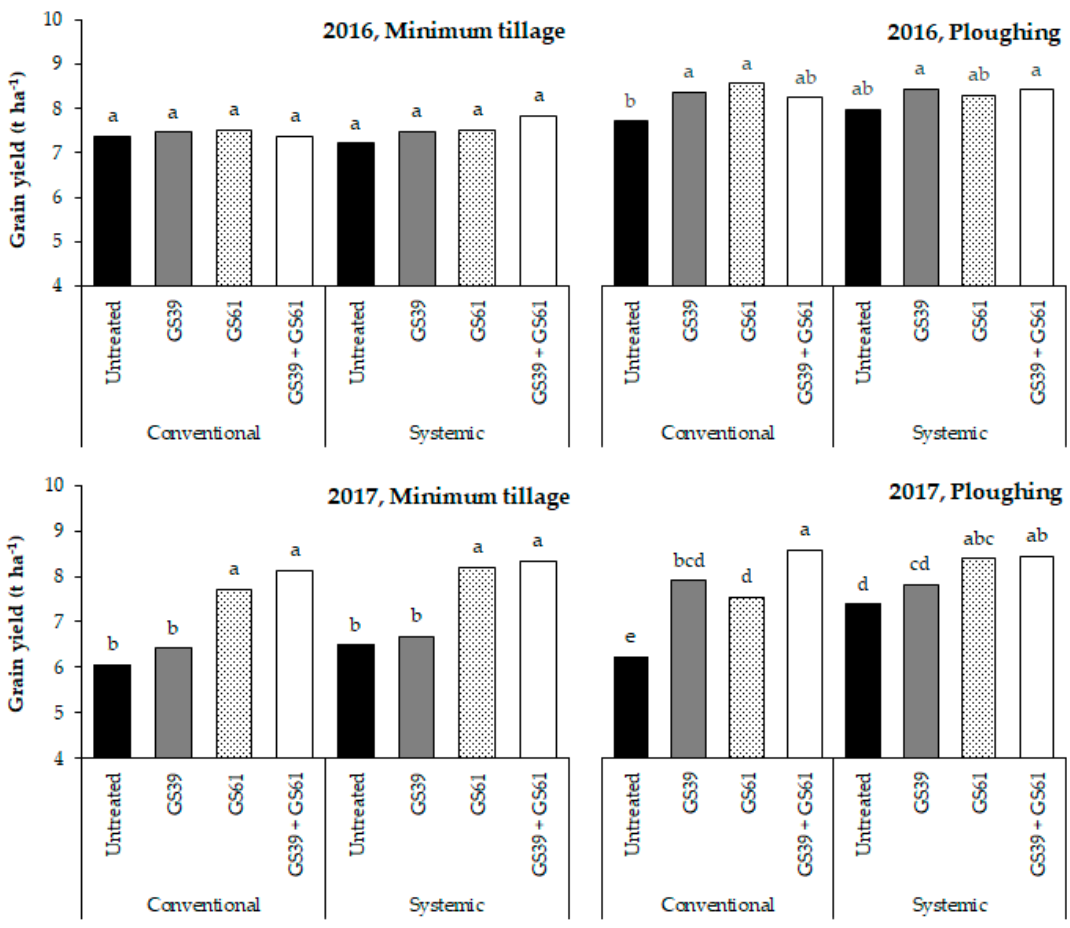
Figure 4. Effect of the fungicide seed 1 and foliar 2 treatments on the grain yield under different soil tillage conditions and in different growing seasons (2015–2016 and 2016–2017) in North-Italy. The bars in each experiment with different letters are significantly different ( p -value < 0.05), according to the REGW-F test. The reported values are based on four replica- tions. 1 Fungicide seed treatments: conventional (fludioxonil AI) and systemic (fluxapyroxad AI); 2 Fungicide foliar treat- ment: untreated control; GS39, a single treatment at the end of stem elongation (pyraclostrobin + fluxapyroxad AI); GS61, a single treatment at the beginning of flowering (epossiconazole + metconazole AI); GS39 + GS61, a double treatment through a combination of the GS39 and GS61 applications.